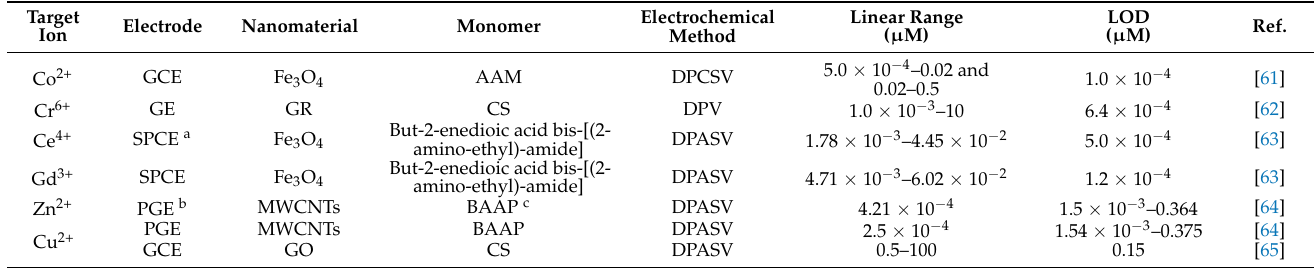
Table 1. Summary of the HMIIECSs prepared by in-situ polymerization. Target